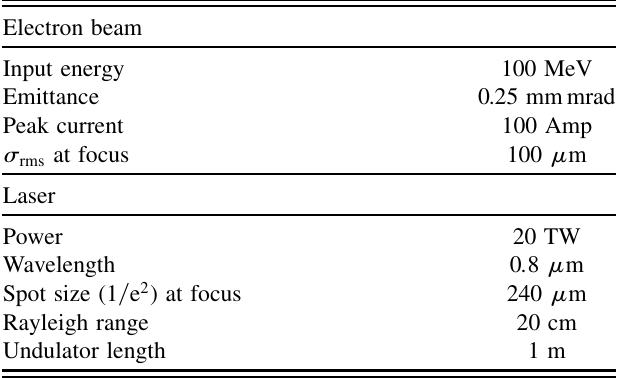
TABLE I. Inverse free electron laser accelerator parameters. Electron